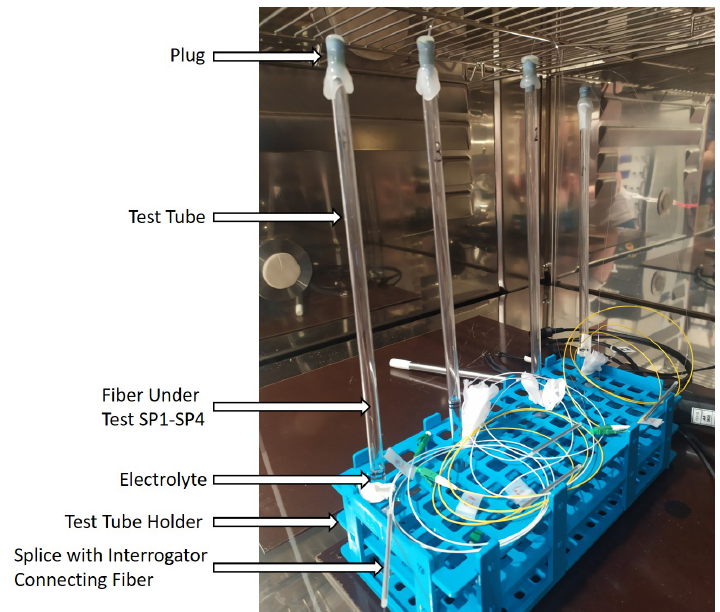
Figure 2. Setup of the electrolyte measurement in the climatic chamber. Test tubes filled with the electrolyte and the inserted fibers in a test tube